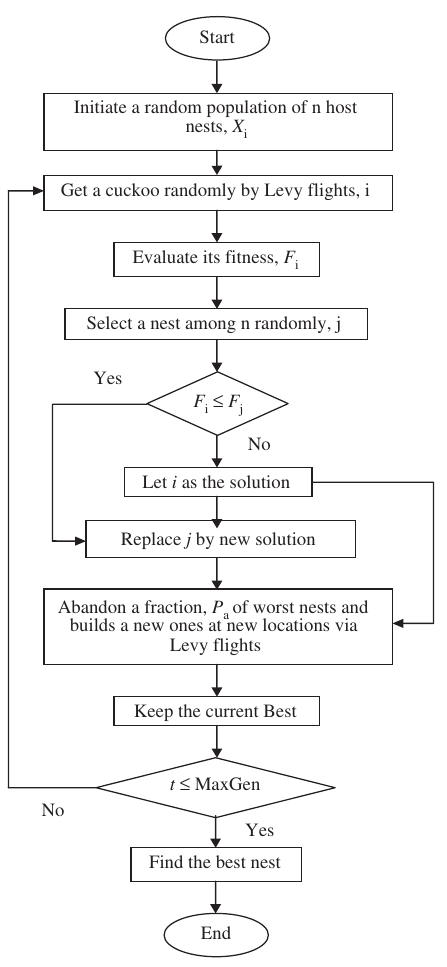
Figure 1: Flowchart of the CS